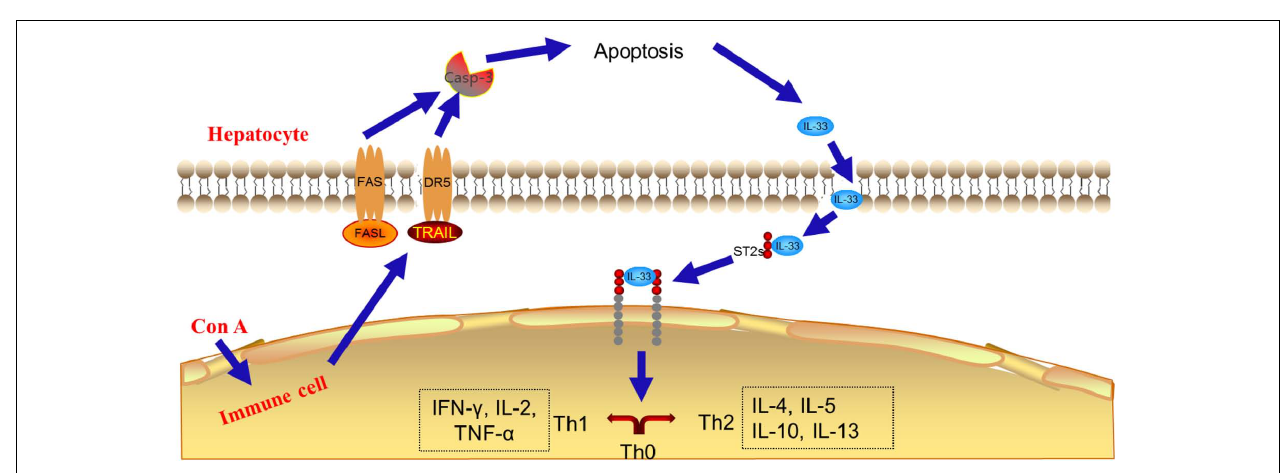
FIGURE 9 | The summarized action pathway of SCG on Con A-induced liver injury.